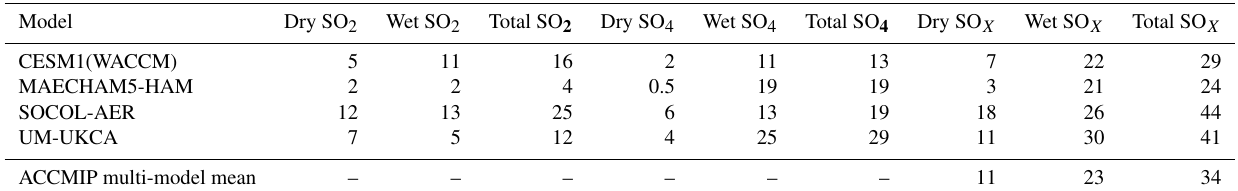
Figure 1. Preindustrial background annual dry, wet and total (wet + dry) sulfate deposition fluxes (kgSO 4 km − 2 yr − 1 ) (left to right) for each model (top to bottom). The value shown in the top right-hand corner of each plot refers to the global mean sulfate deposition flux. Background fluxes are averages of the annual deposition from five control simulations each with 4 years of data for UM-UKCA, three controls each with 5 years of data for CESM1(WACCM) and one control with 5 years of data for MAECHAM5-HAM and SOCOL-AER. Table 3. Annual global deposition fluxes of SO 2 , SO 4 and SO X (SO 2 + SO 4 ) for dry deposition, wet deposition and total dry + wet (TgSyr − 1 ) in the preindustrial controls and in the ACCMIP multi-model mean (see text).